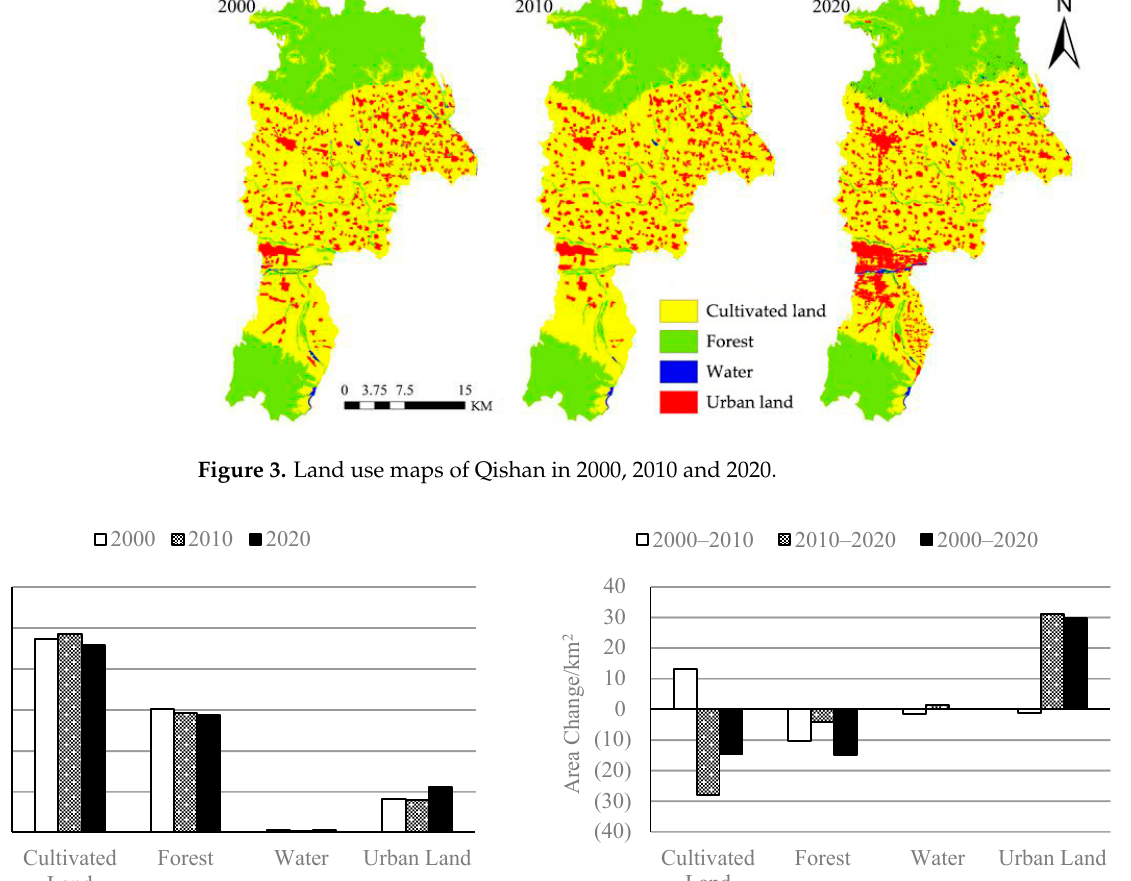
Table 3. Dynamic degree of land use change in Qishan from 2000 to 2020. Land Use Type Single Dynamic Degree